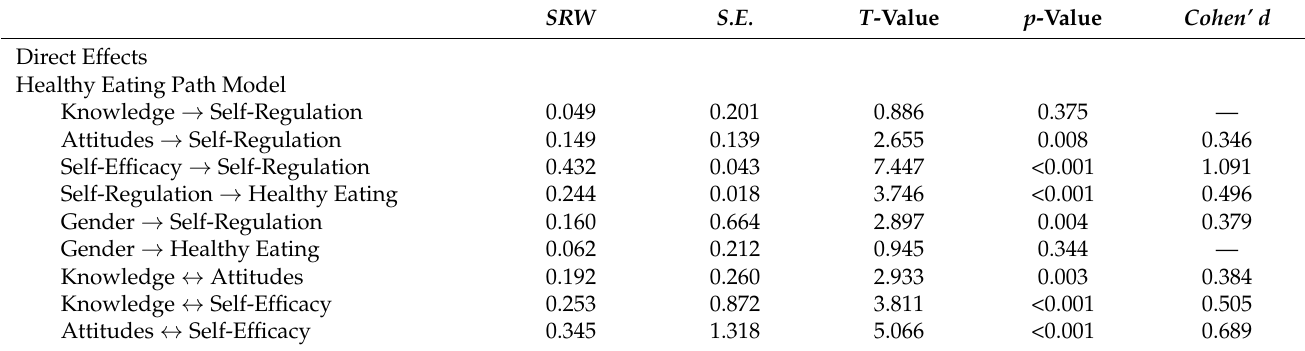
Table 2. Standardized regression coefficients of the explanatory model of food consumption ( N =